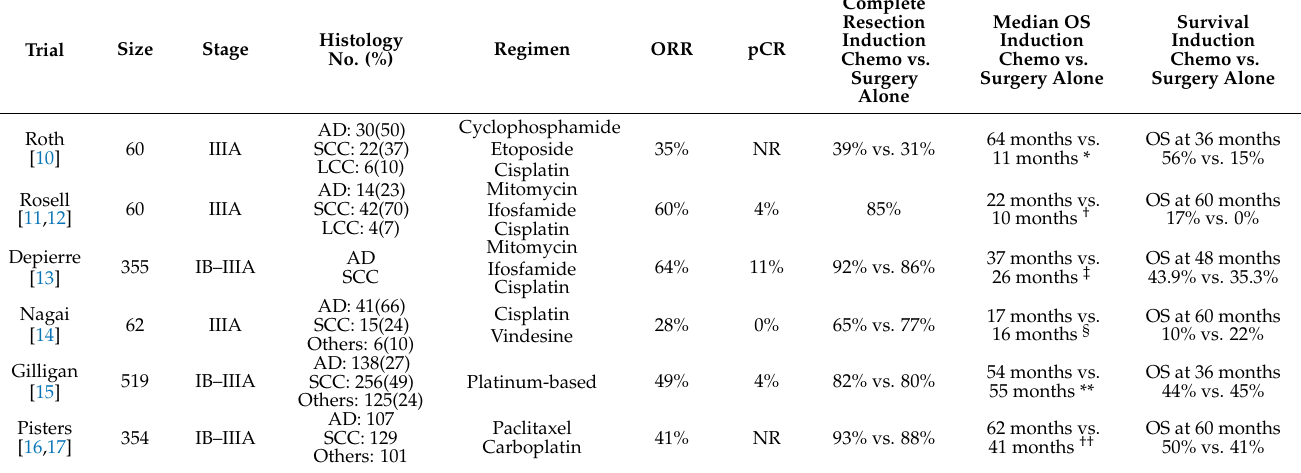
Table 1. Phase III clinical trials of neoadjuvant